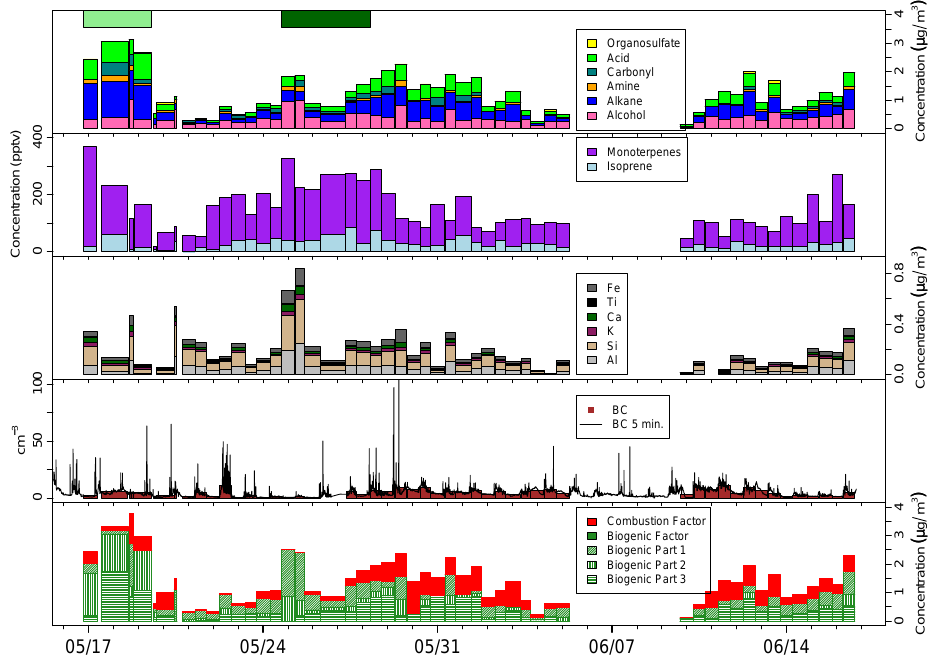
Fig. 2. Time series of measured and calculated submicron aerosol components with H1 (light green) and H2 (dark green) marked by top colored bars: (a) Time series of OM and OFG as stacked bars: organic hydroxyl (pink), alkane (blue), ketone (teal), amine (orange), acid (green), organosulfate (yellow) group concentrations; (b) shows the sum of isoprene (light blue) and monoterpenes (purple) concentration; (c) dust components Al (light grey), Si (tan), K (maroon), Ca (dark green), Ti (black), Fe(dark grey); (d) Time series of 5 min average BC measurements (black) and ∼ 12 h averages (brown); (e) Time series of OM reconstructed from four-factor PMF.